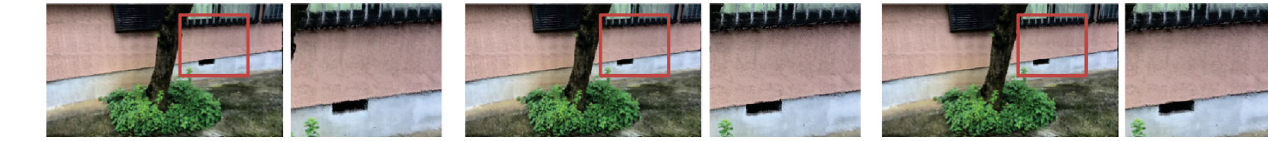
Fig. 9 Background restoration for consecutive frames of Scene 2.